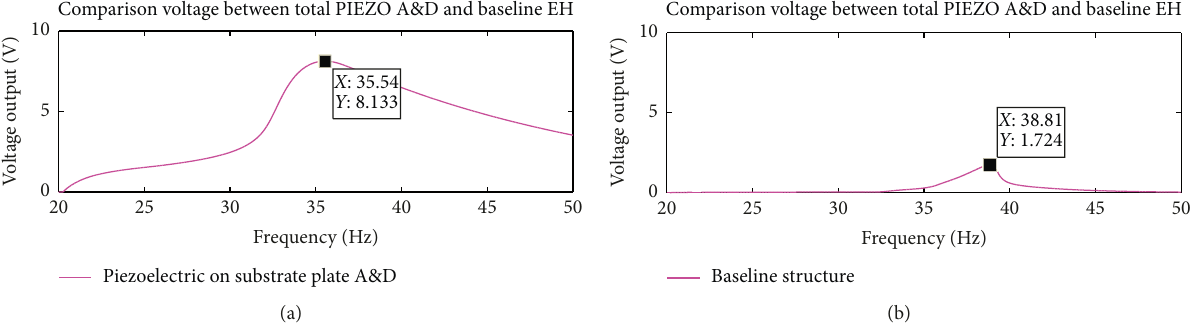
Figure 14: Voltage response between PIEZO A&D and baseline EH (PIEZO A&D: the sum of piezoelectric on substrate plate A and D; baseline EH: the baseline energy